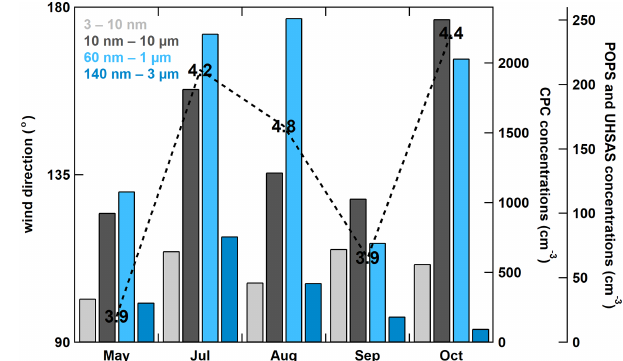
Figure 6. Ground-based monthly averaged wind direction at Olik- tok Point from days where the TBS flew. The black numbers for the wind direction markers indicate the average wind speed (in ms − 1 ). Colored bars indicate the monthly averaged aerosol number con- centrations measured by the CPCf (10nm–10µm), UHSAS (60nm– 1µm), and POPS (140nm–3µm). The difference between the CPCu and CPCf is shown as the 3–10nm particles. Note the CPCs and UHSA and POPS are shown on different axes. The POPS concen- trations are averaged from those measured at all below-cloud alti- tudes (20m to cloud base), while the remaining aerosol instruments and wind measurements were only surface based (instrumentation included in the AMF3).